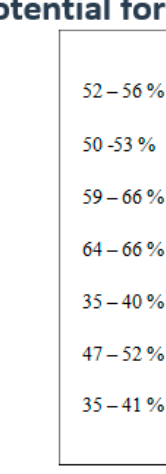
Figure 5. Sectors with the highest job vacancies and potential for automation.